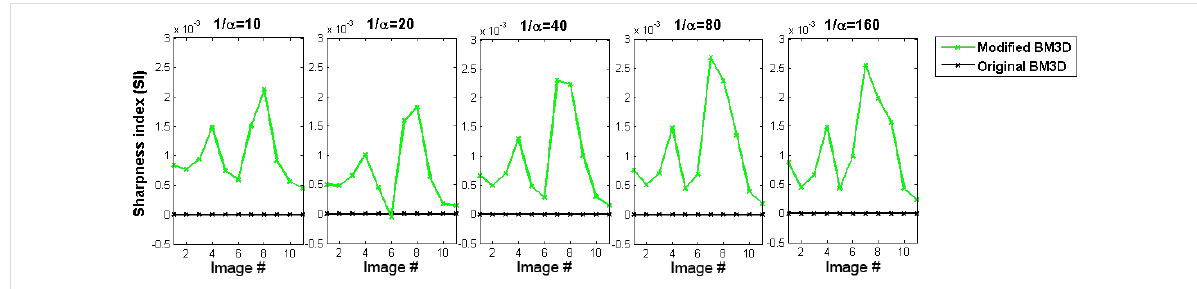
Figure 6: Sharpness index of reconstructions by the original and the modified version of the BM3D algorithm. Lower values of the parameter 1/ α imply higher noise variances. Positive values for almost all images tested indicate an improved sharpness of the modified BM3D algorithm as compared to the original version. Note that this effect is independent of the amount of noise (depending on 1/ α ) contained in the